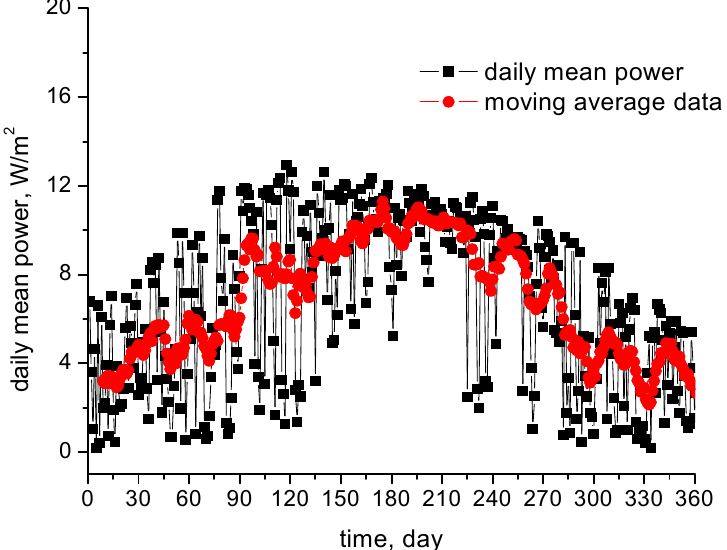
Figure 3. The attenuation of fluctuations with the moving average ( n = 6) of the time series data. The value n = 6 seemed to be optimal for smoothing the data over the entire year. The above graph highlights the fact that the smallest production values were in winter, i.e., at